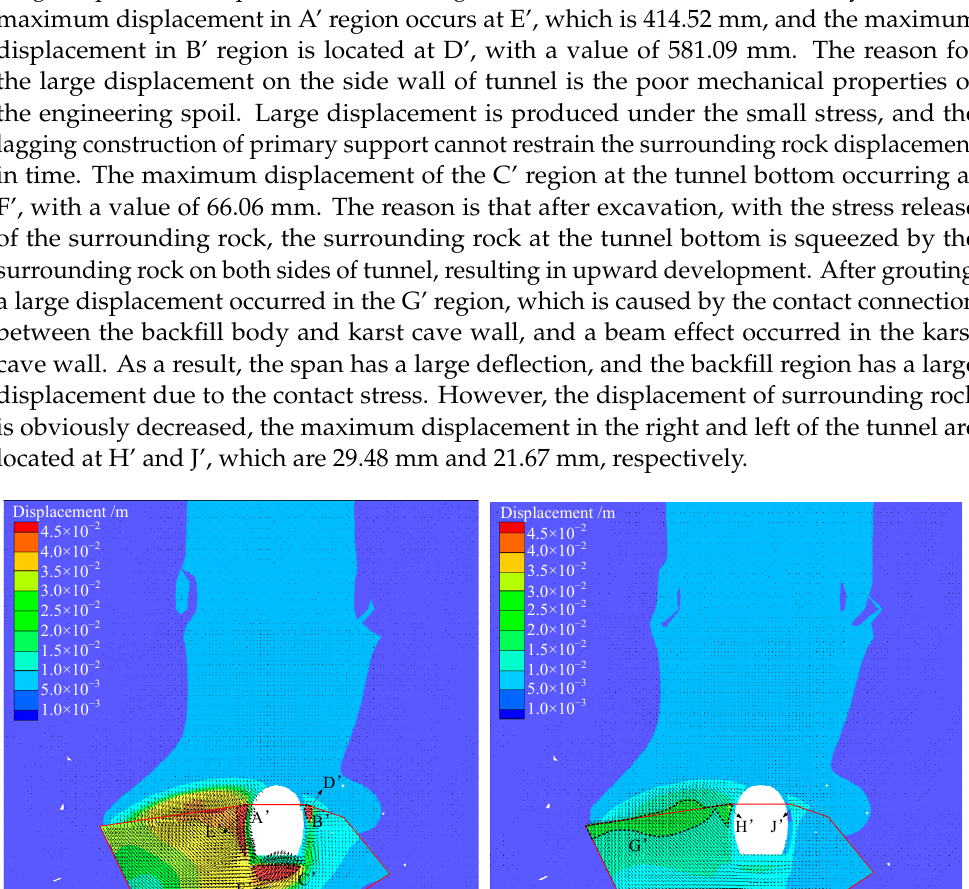
kN × m, respectively, the maximum bending moment at the tunnel bottom is − 99.14 kN ×